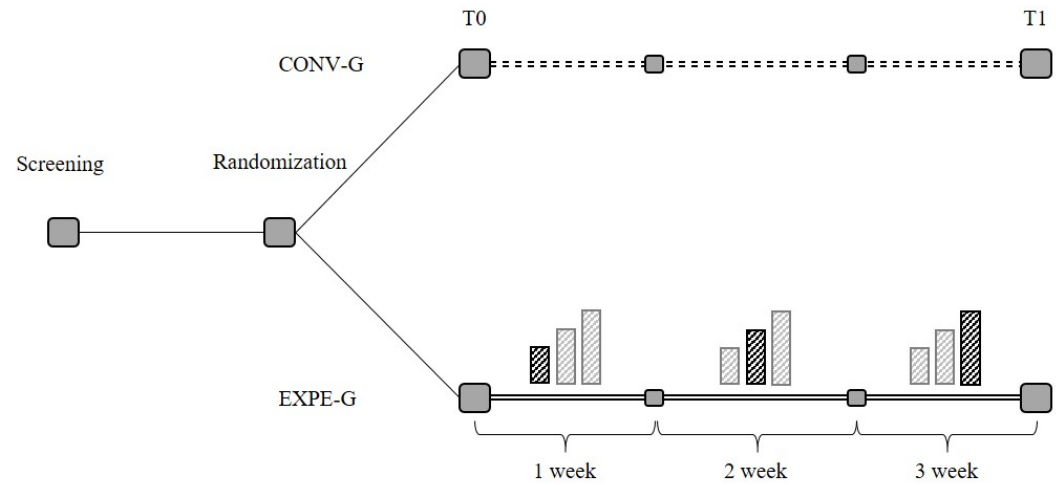
Figure 1. Design of the study.